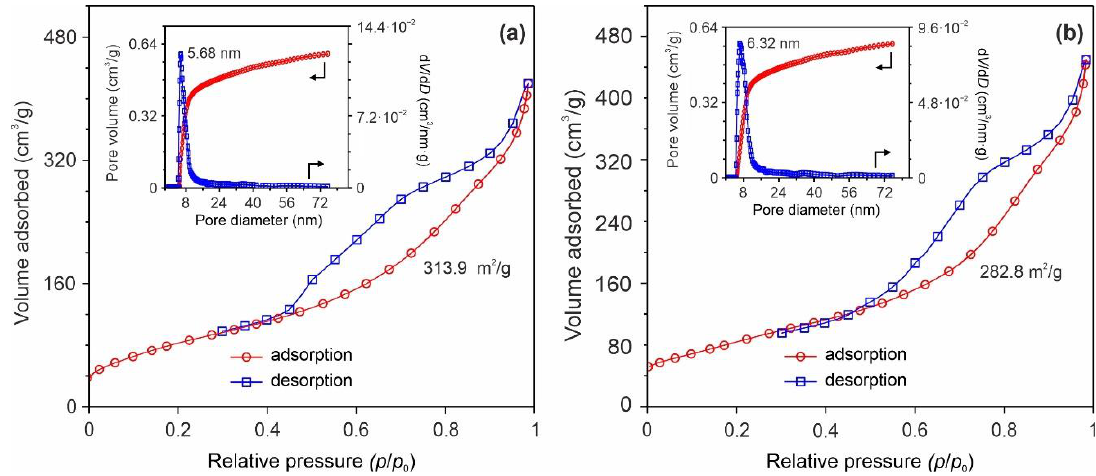
Figure 4. Data of adsorption measurements for NTO-120 ( a ) and NTO-350 ( b )